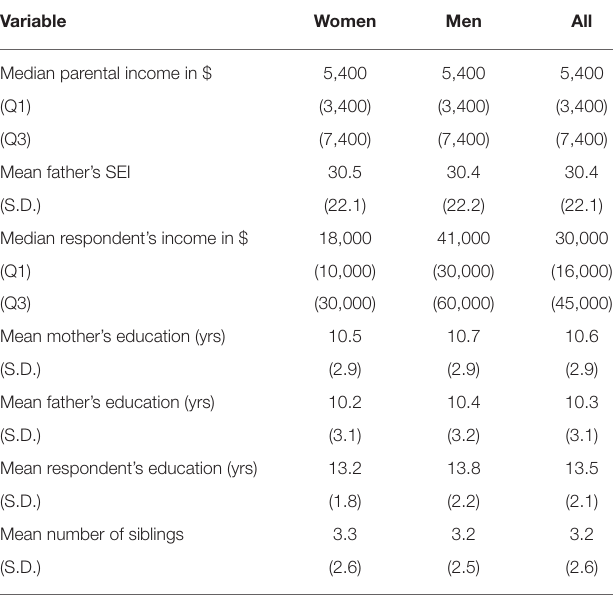
TABLE 1 | Descriptive statistics: model women and model men. Variable